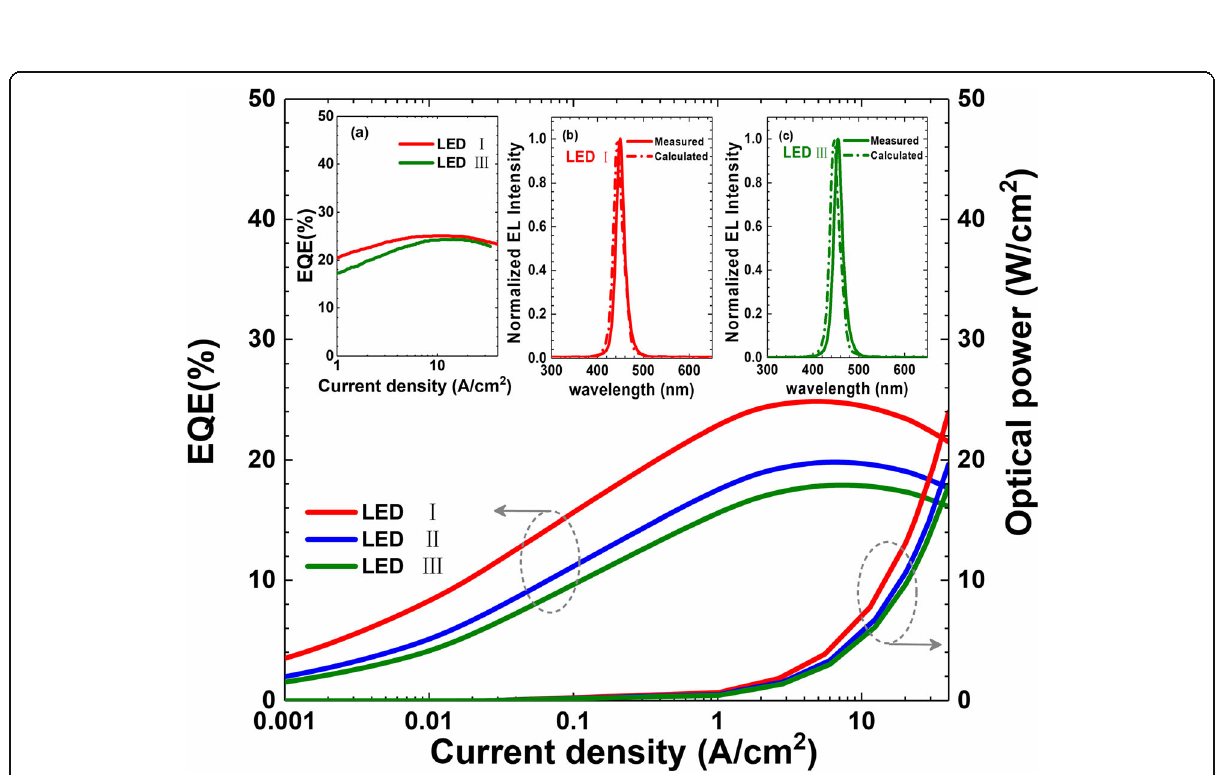
Fig. 6 Calculated EQE and optical power density in terms of the injection current density for μ LEDs I, II, and III, respectively. Inset Fig of ( a ) shows the experimentally measured EQE for μ LEDs I and III, respectively. Inset figures of ( b ) and ( c ) present the measured and numerically calculated EL spectra for μ LEDs I, and III. Data for inset Figs ( b ) and ( c ) are collected at the current density of 40 A ∕ cm 2